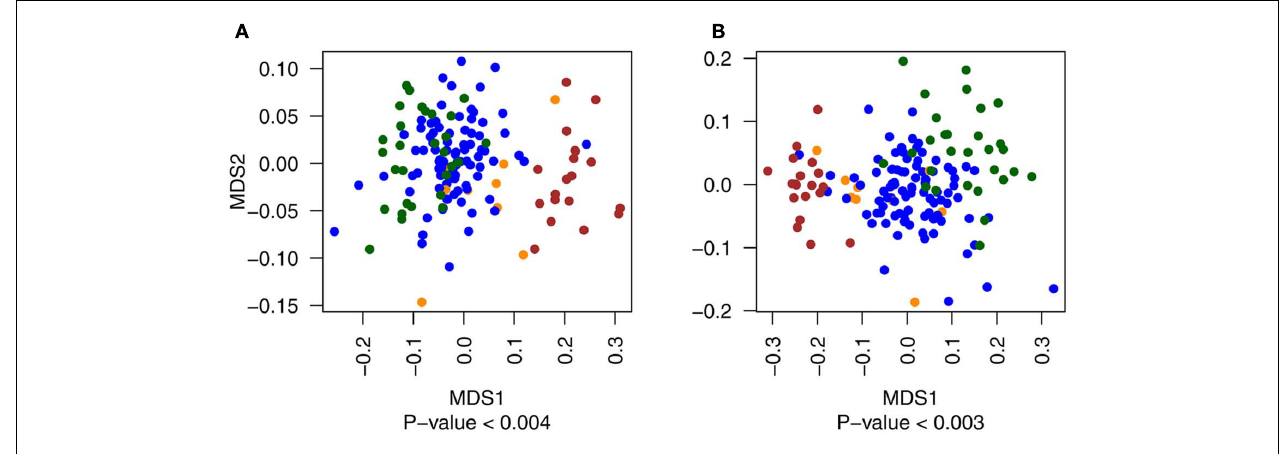
(green) tissues for exonic (A) and non-exonic (B) features. Metastatic and normal data points are included in the figure for illustrative purposes only.